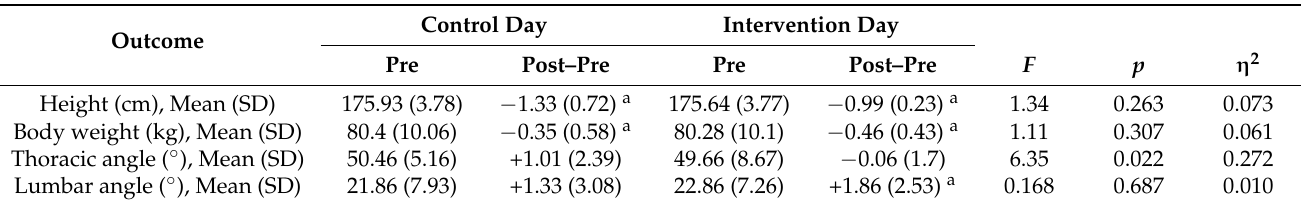
Table 1. Characteristics and differences post–pre workday of the participants ( N =